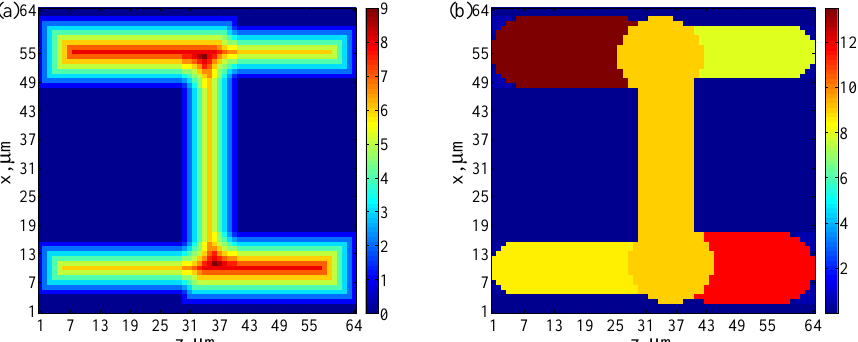
Figure 15. ( a ) Distribution of d for a one-cell-thick layer of model three. ( b ) Distribution of w for a one-cell-thick layer of model three.